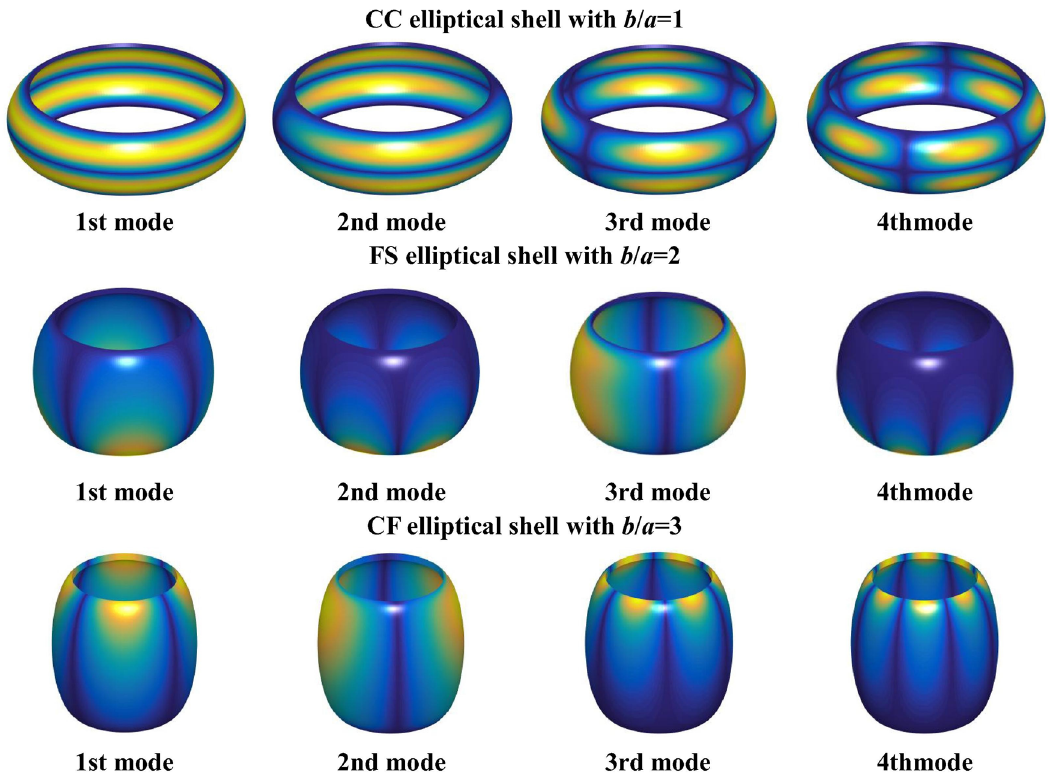
Figure 9: The fi rst four lowest mode shapes of UD - CNTRC elliptical shell with various b / a [ 144 ] ; a and b are characteristic parameters of the hyperbolic